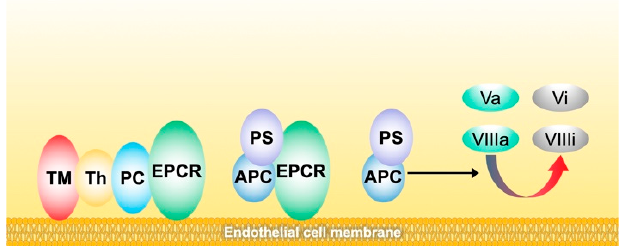
Figure 3. Schematic representation of the activation of protein C on the membrane of endothelial cells and the mechanism of action of the complex of activated protein C/protein S in inhibiting factor Va and factor VIIIa. Instrumental to the mechanism are two endothelial receptors, thrombomodulin (TM) that binds thrombin (Th) and endothelial protein C receptor (EPCR) that binds plasma protein C (PC). The proximity of the above receptors localizes the conversion of the substrate (PC) by the enzyme (Th) into activated PC (APC). APC in complex with its plasmatic cofactor protein S (PS) eventually inhibits factors Va and VIIIa, thus, downregulating thrombin production.